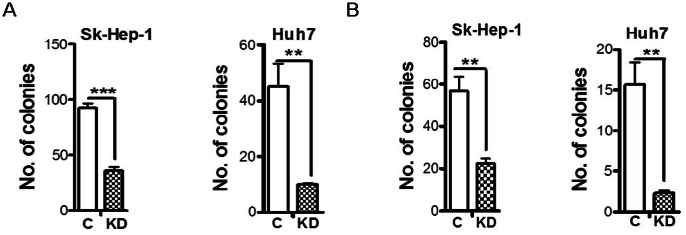
Attenuated potential of in vitro tumorigenic and metastatic potential of Sk-Hep-1 and Huh7 cells after Smad4 knockdown.Soft-agar (A) and hard-agar (B) colony formation ability was assessed in the control and Smad4 knockdown Sk-Hep-1 and Huh7 cells for 14 days. The colonies were stained and counted. Each data point represents mean±SEM from three independent wells. **, p<0.01; ***, p<0.001.